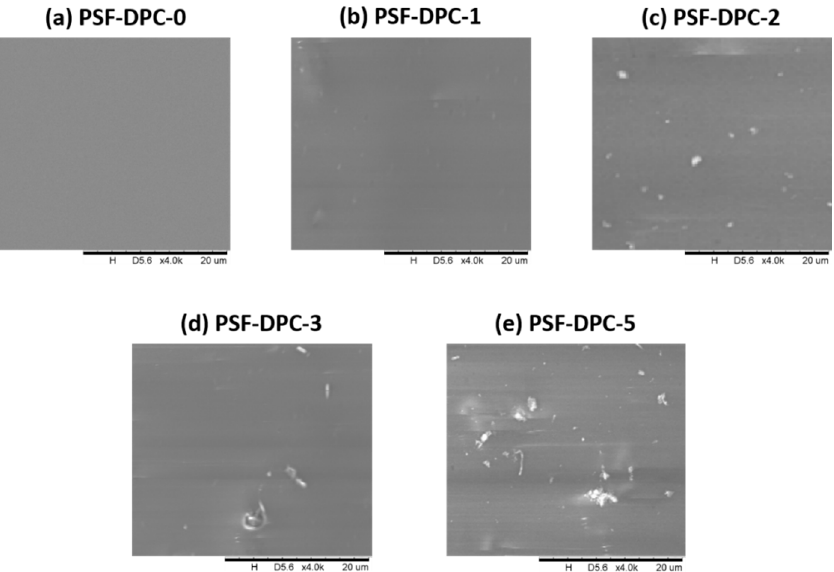
Figure 2. Surface SEM of DPC composite membrane for ( a ) PSF-DPC-0, ( b ) PSF-DPC-1, ( c ) PSF-DPC-2, ( d ) PSF-DPC-3, and ( e ) PSF-DPC-5, for the pure PSF membrane and the CMB’s with the DPC loads of 1 wt%, 2 wt%, 3 wt%, and 5 wt%, respectively.